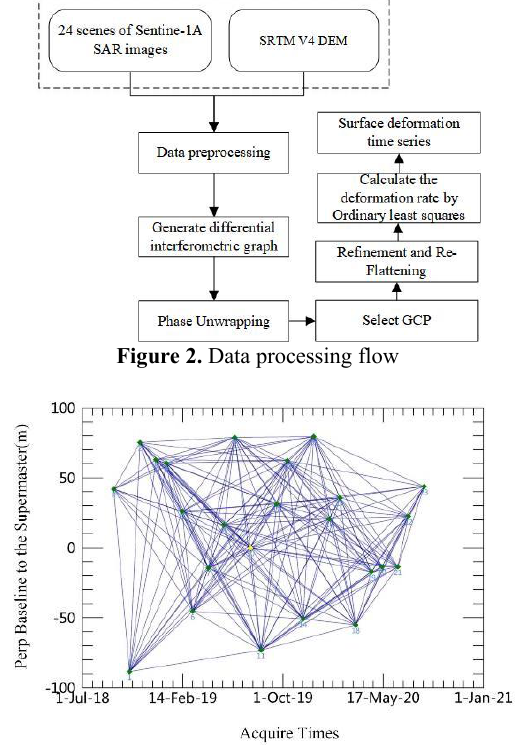
Figure 3. Temporal and spatial baseline distribution of the interference graph